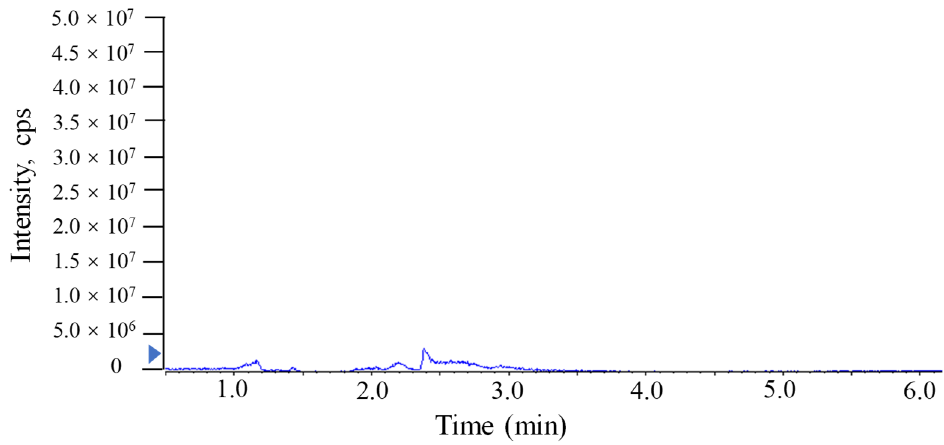
Figure 5. MRM chromatograms of TTX in procedural blank sample analyzed by UPLC-MS/MS with a Waters ACQUITY UPLC BEH Amide column.